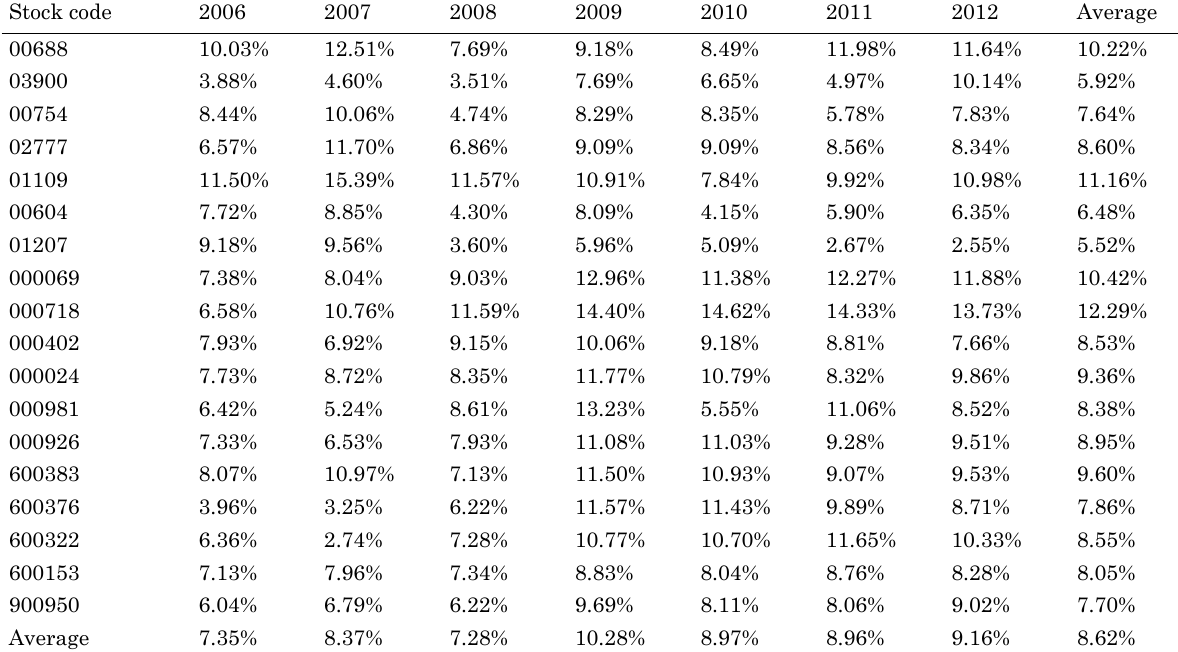
Table 5. WACC of the 18 mainland companies during the period 2006–2012 Stock